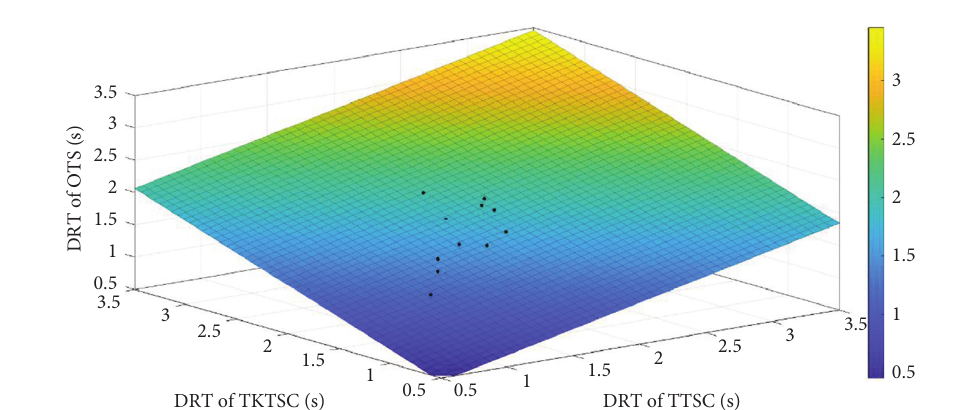
Figure 11: The visualization of the results.